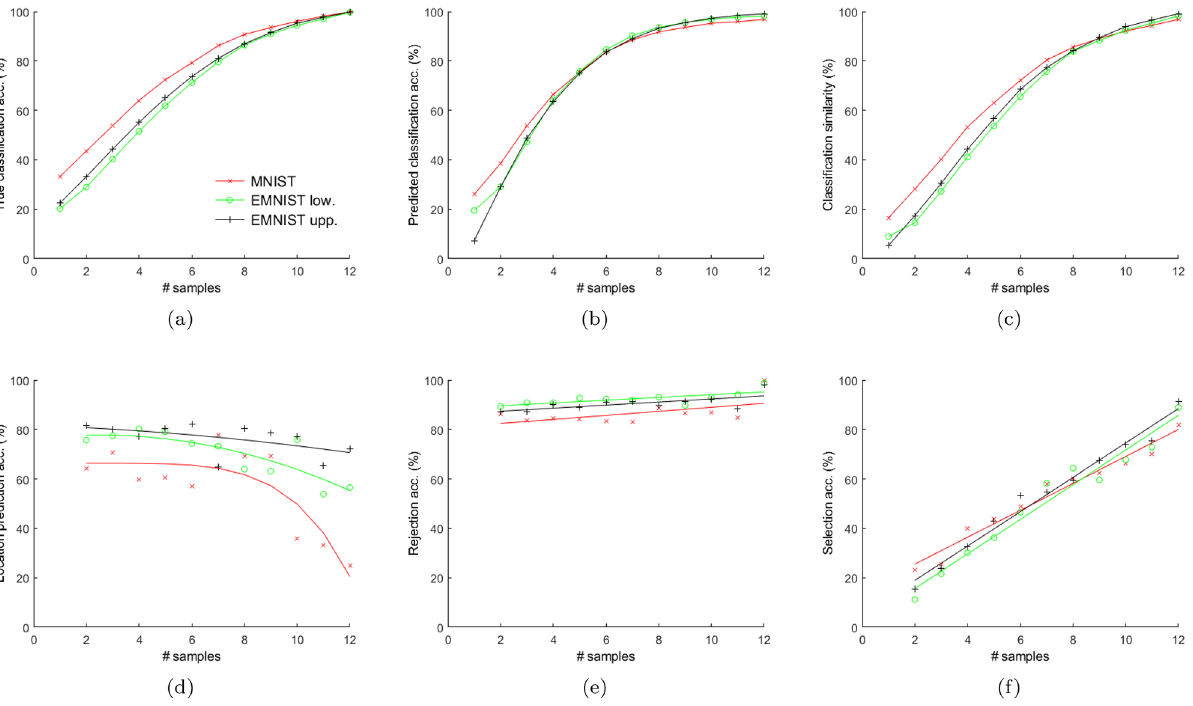
Figure 5. Evaluation of our baseline model (ref. “Baseline for behavior prediction” Section). ( a ) Classification accuracy (acc.) of the participants and ( b ) that of our baseline model with actual labels as ground truth. ( c ) Classification similarity ( J ( c t , ˆ c t ) ), ( d ) location prediction accuracy, ( e ) class rejection accuracy and ( f ) class selection accuracy of our baseline model with participants’ data as ground truth. See “Behavior prediction” section for details.